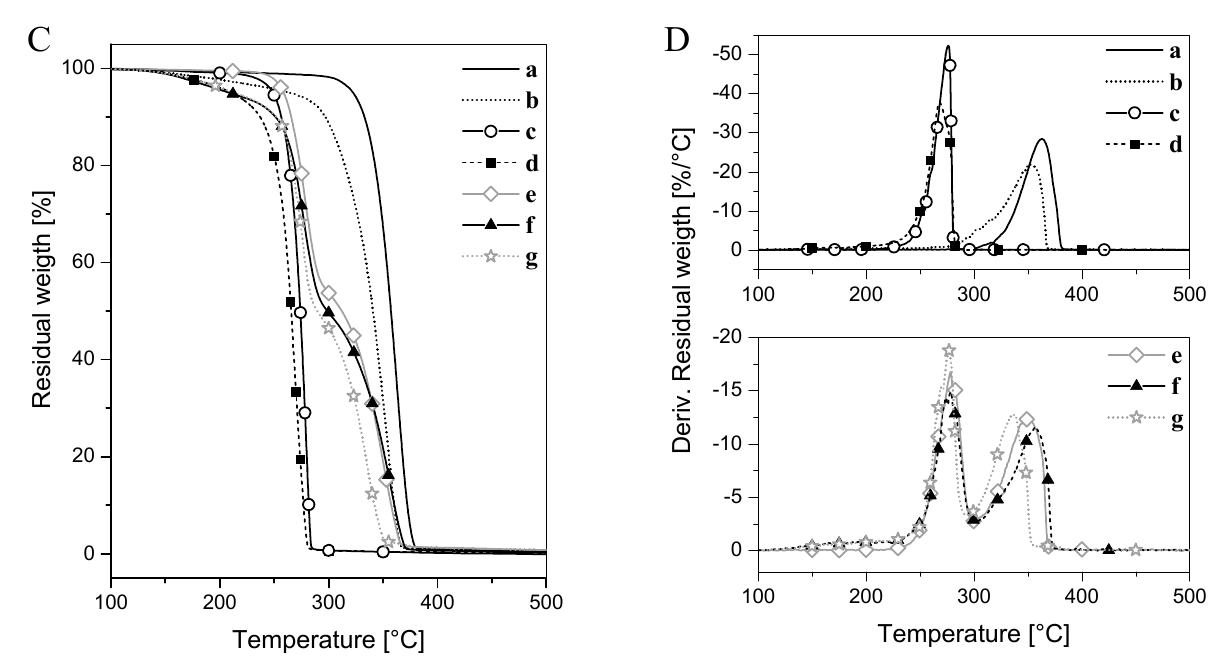
Figure 9. Thermal analysis results of (a) PLA, (b) PLA/TB, (c) PHB, (d) PHB/TB, (e) PLA/PHB, (f) PLA/PHB/TB, and (g) PLA/PHB/TB/ChNP: ( A ) DSC first and ( B ) second heating scans; ( C ) TG and ( D ) DTG thermograms.